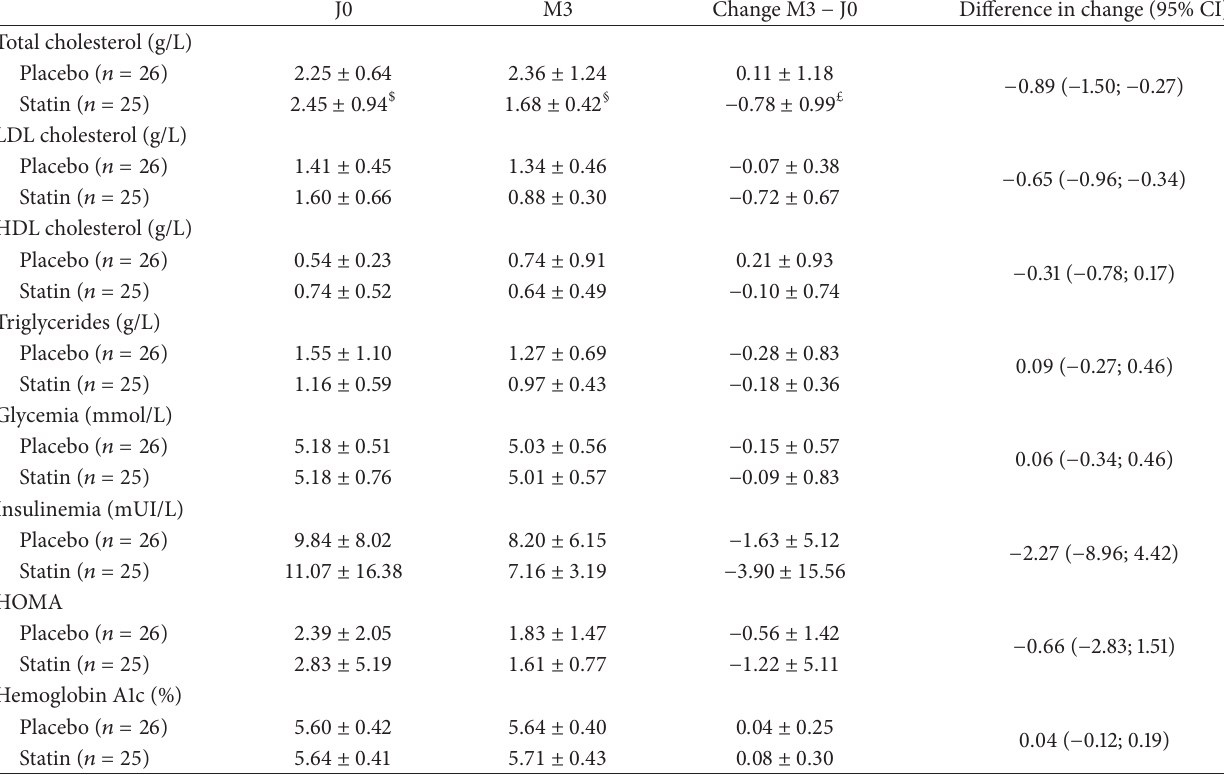
Table 4: Metabolic parameters at baseline (J0) and after 12 weeks (M3) of placebo or statin treatment. J0